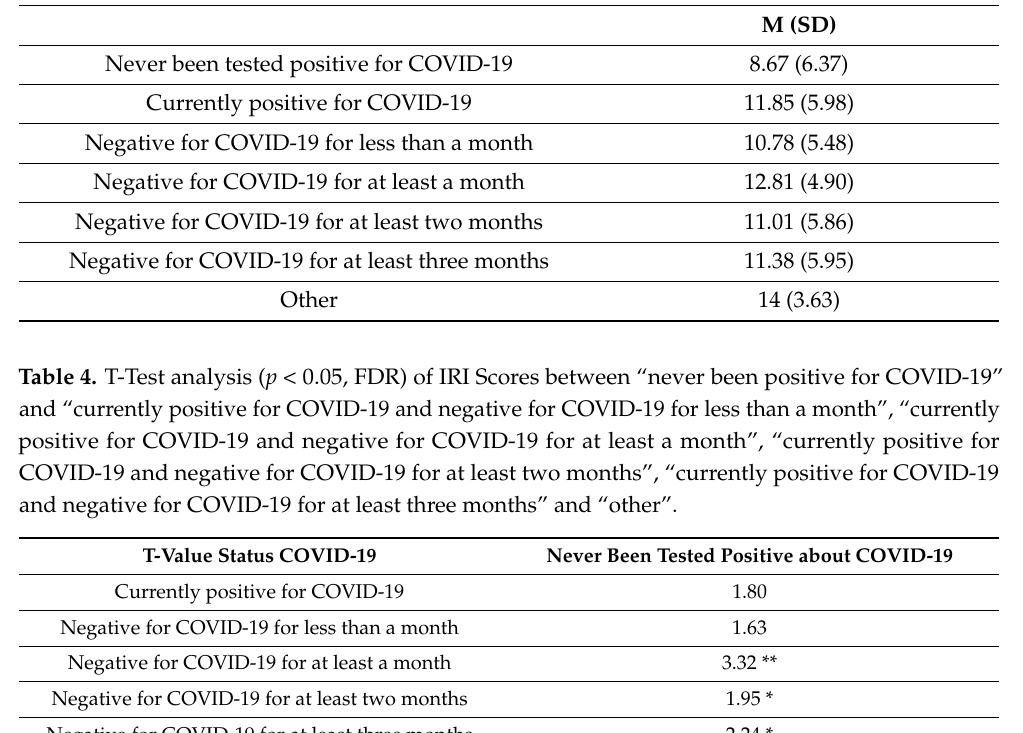
Never been tested positive for COVID-19